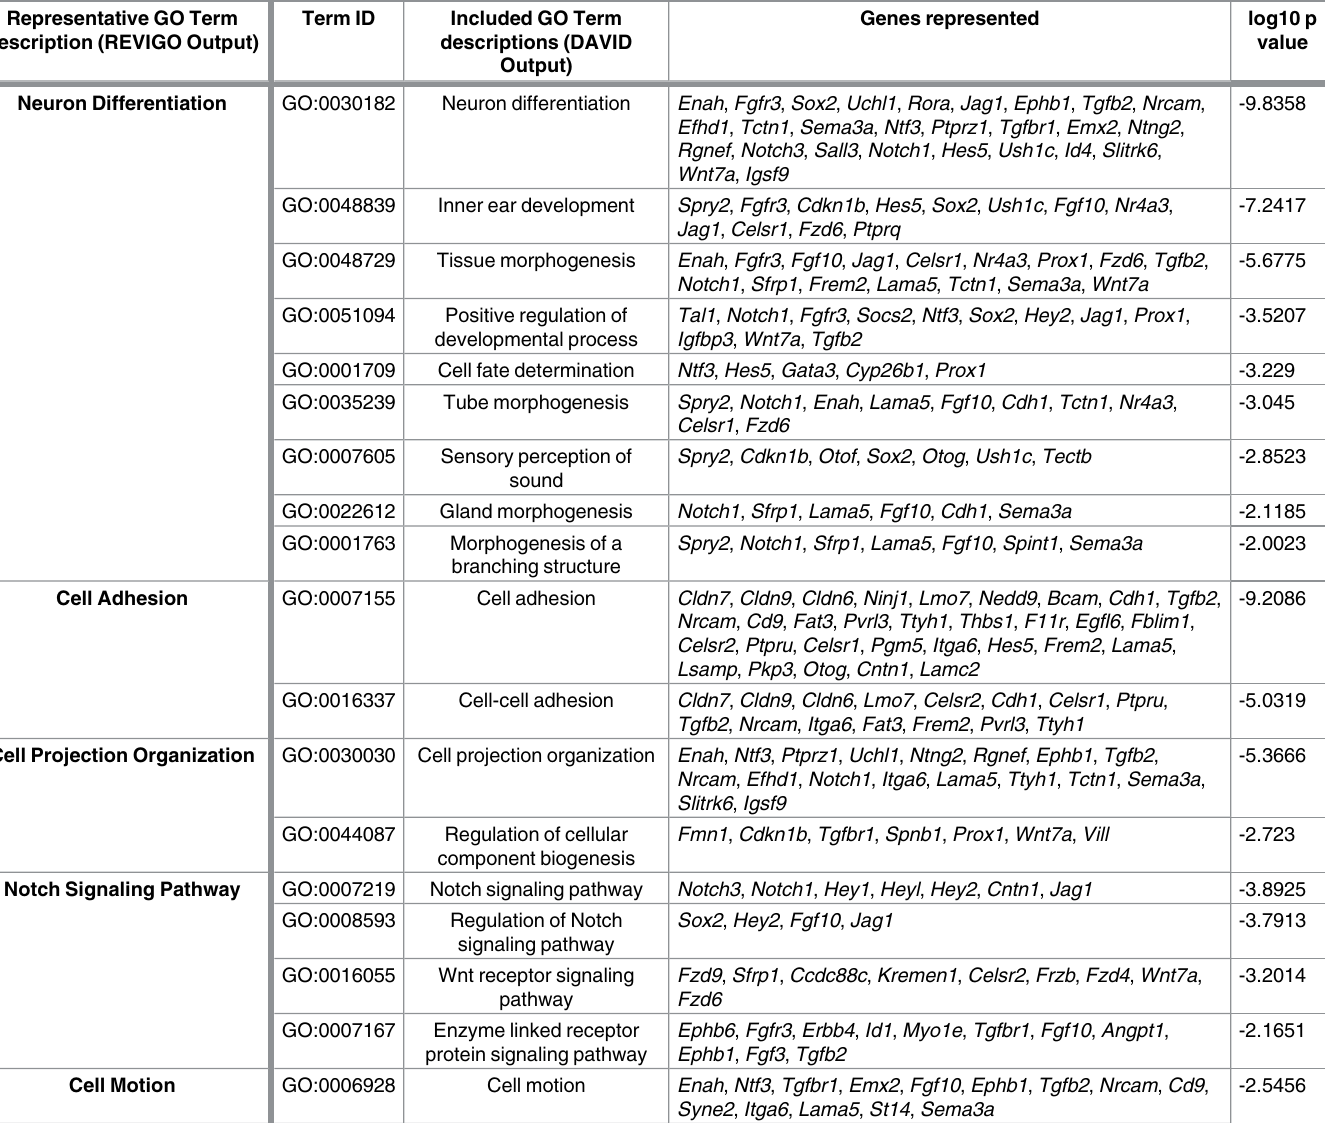
Table 5. Biological processes(BP) GO terms represented in the genes enriched in P1 Lfng-GFP + cells. Representative GO Term description (REVIGO